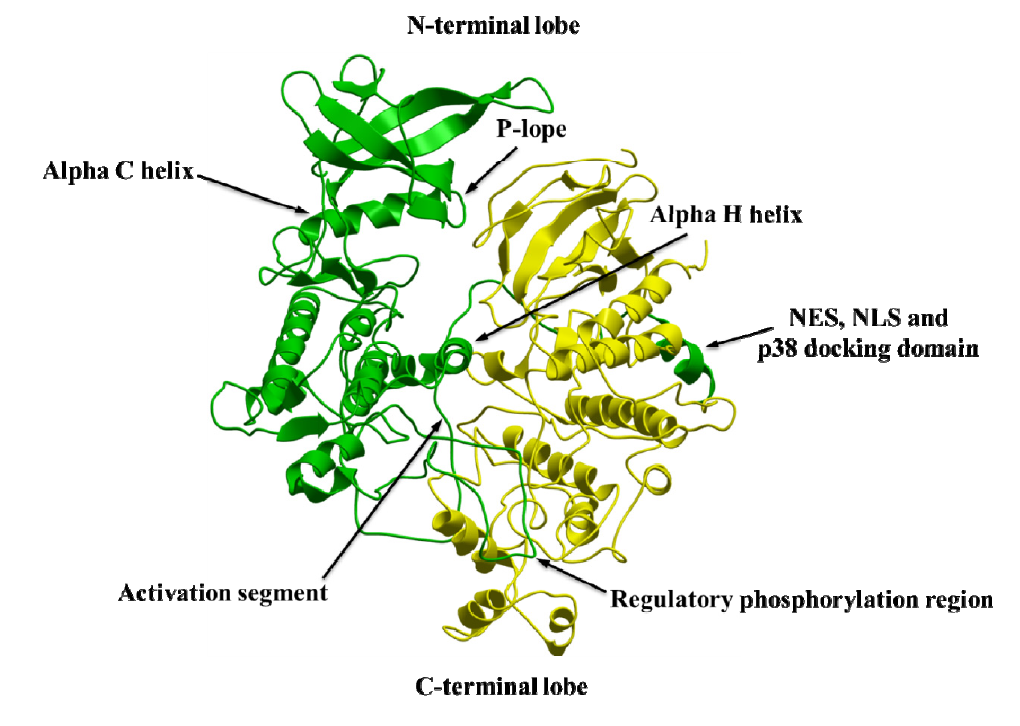
Figure 10. The model of MK5 (green) in complex with p38 (yellow), outlining the important structural elements of MK5 interacting with p38. The C α -traces of the proteins are shown.